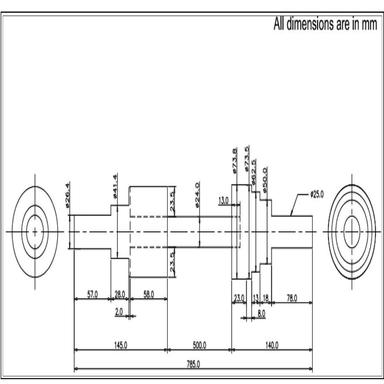
Two dimensional diagram of composite drive shaft.